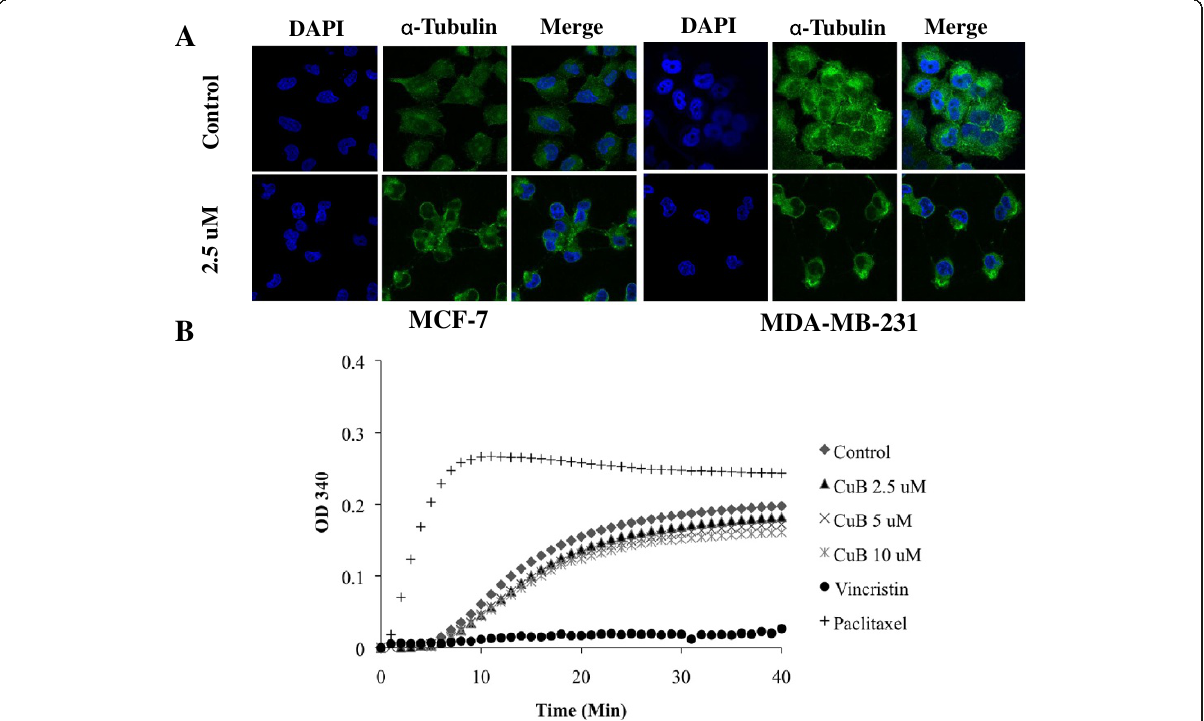
Figure 8 Cucurbitacin B inhibits microtubule polymerization. A . Effect of cucurbitacin B on the organizations of cellular microtubule network. Immunofluorescent staining for α -tubulin was inspected in MCF-7 and MDA-MB-231 cells treated with cucurbitacin B. Cells were fixed, permeabilized and stained with anti- α -tubulin monoclonal antibody. The cells were analyzed using confocal microscopy. DAPI was used for nuclear localization. Change of tubulin organization within the cells was observed after cucurbitacin B treatment. B . Effect of cucurbitacin B on microtubule polymerization in a cell-free system was determined in vitro. Bovine brain tubulin protein (3 mg/mL) was mixed with special reaction buffer as described in materials and method, and incubated with 2.5, 5, 10 μ M cucurbitacin B, 10 μ M vincristine or 10 μ M paclitaxel. The polymerization of tubulin was determined on the basis of the increase in optical density. The O.D. (340 nm) was measured each minute for up to 40 minutes at 37°C using microplate reader. Unlike paclitaxel and vincristine, treatment with cucurbitacin B in cell-free system has no effect on tubulin